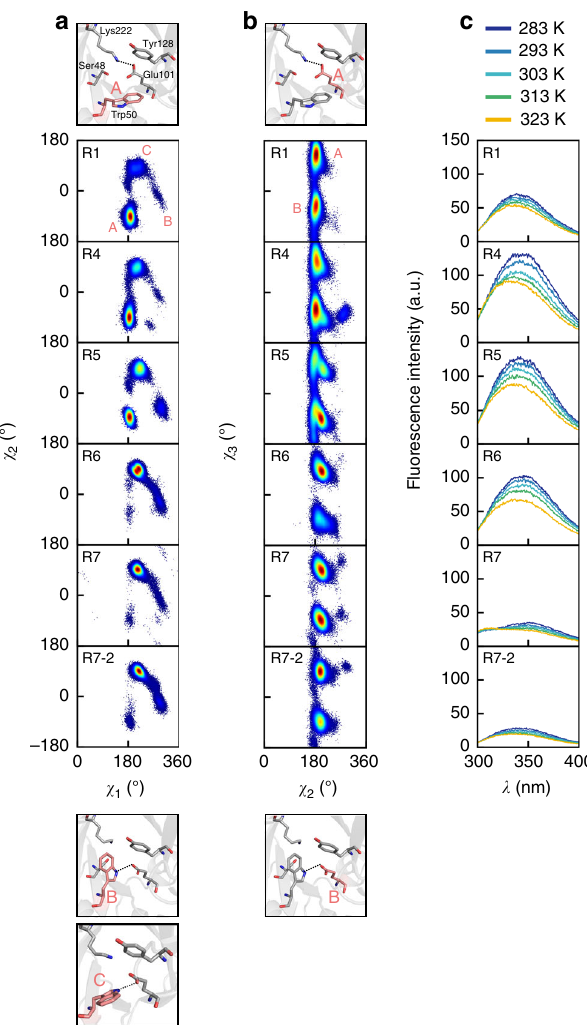
Fig. 3 Molecular dynamics and tryptophan fl uorescence of KE07 variants. Conformational sampling of a Trp50 and b Glu101 during KE07 evolution in Hamiltonian replica exchange molecular dynamics (HREX-MD) simulations and c tryptophan fl uorescence spectra over a temperature range 283 − 323 K. The dihedral angle distributions of Trp50 ( a ) and Glu101 ( b ) of the KE07 variants (R1 to R7-2) are shown. Initial Trp50 conformations, together with the backbone RMSD pro fi les, are shown in Supplementary Fig. 7. The atoms used for dihedral angle analysis are χ 1: N:CA:CB:CG, χ 2: CA:CB:CG:CD1 of Trp50 ( a ). χ 2: CA:CB:CG:CD, χ 3: CB:CG:CD:OE1 of Glu101. The protein structures indicate the labeling used for the different Trp50 and Glu101 conformers sampled by KE07 variants. c Fluorescence emission spectra (excitation at 280 nm) were measured at 283 − 323 K (temperatures for each spectra are indicated with different colors). The fl uorescence spectra of Trp50Ala mutants (R1_Trp50Ala and R7-2_Trp50Ala) are shown in